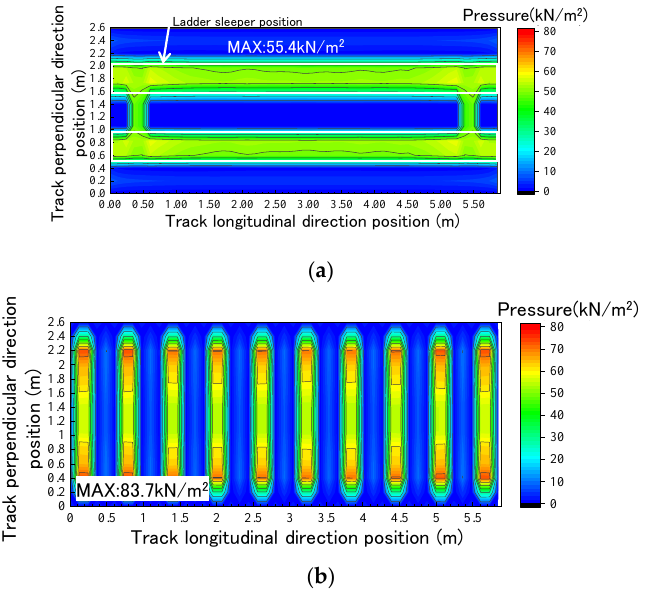
Figure 16. Analysis results of train running (CASE2): ( a ) time-history waveform of pressure on sleeper bottom plane of each sleeper; ( b ) frequency characteristics of pressure on sleeper bottom plane of each sleeper.